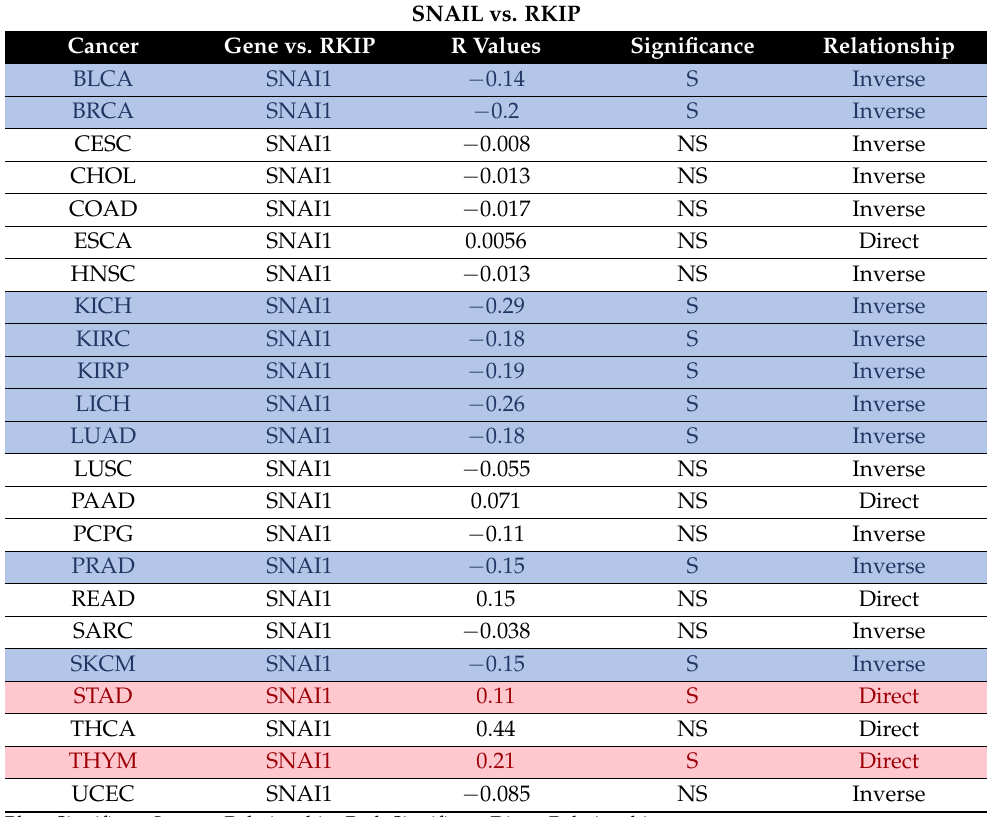
Table 1. RKIP vs. Snail. A bioinformatic analysis was performed across 23 different cancer types comparing the presence of RKIP against Snail. From this data, a p -value and an R value were determined for each of the cancer types. The table above organized the bioinformatic data. For each cancer type, the R value was reported in the third column. Significance was determined based on the p -value, with a p -value less than 0.05 indicating a significant value. The relationship between RKIP and Snail was determined through the sign of the R value. A negative R value indicated an inverse relationship while a positive R value indicated a direct relationship. The rows highlighted in blue indicate a significant, inverse relationship between RKIP and Snail. The rows highlighted in red indicate a significant, direct relationship between RKIP and Snail.